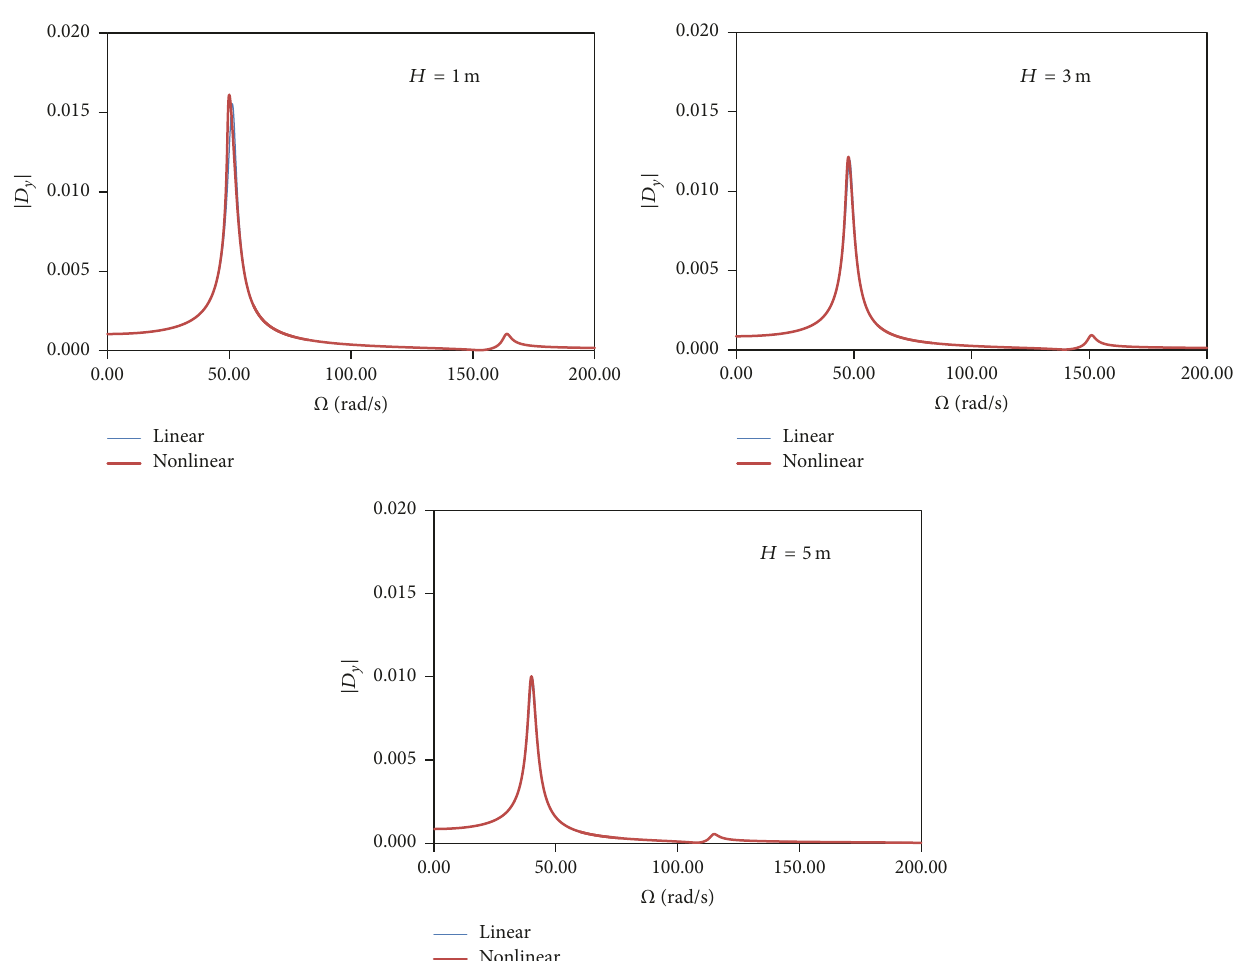
Figure 11: Influence of the roof height on the nonlinear response of the arched-roof frame under vertical excitation. 𝐴 𝑦 = 0.96𝑔 .